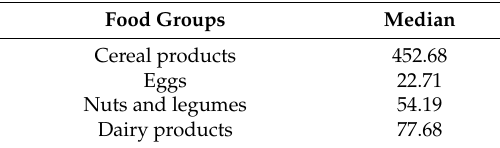
Table 2. Median of food intake for each